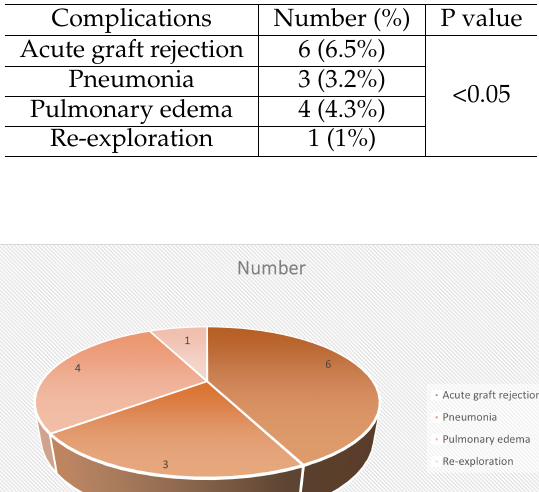
Table 3. Postoperative complications in renal transplant recipients.